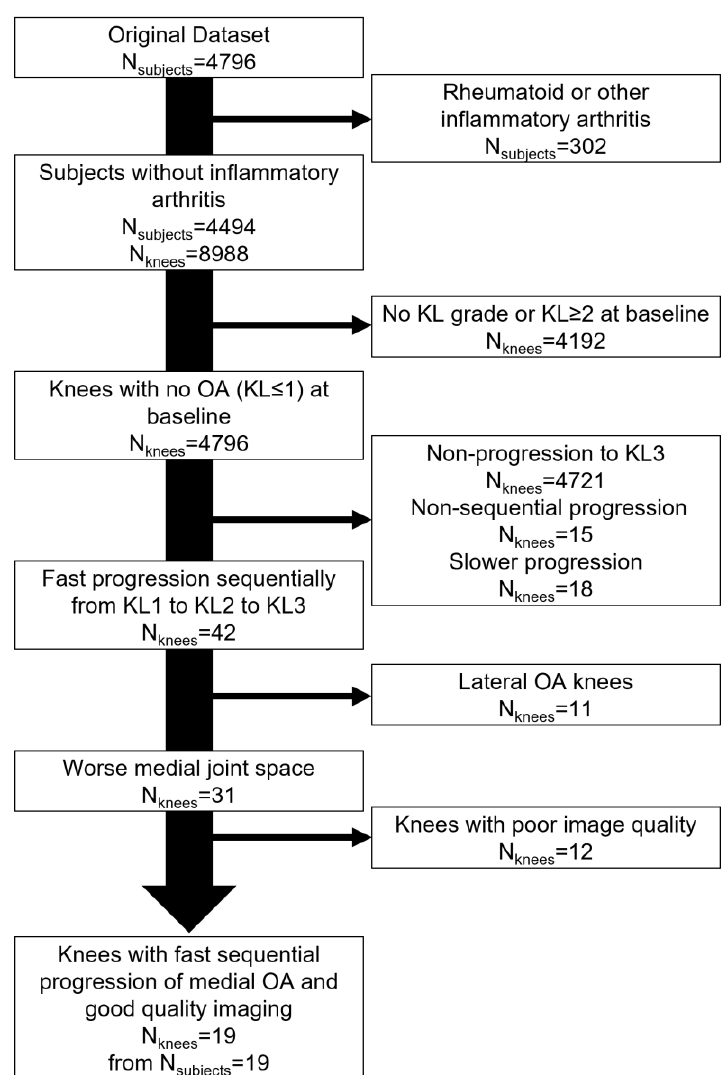
Figure 1. Flowchart of study inclusion.